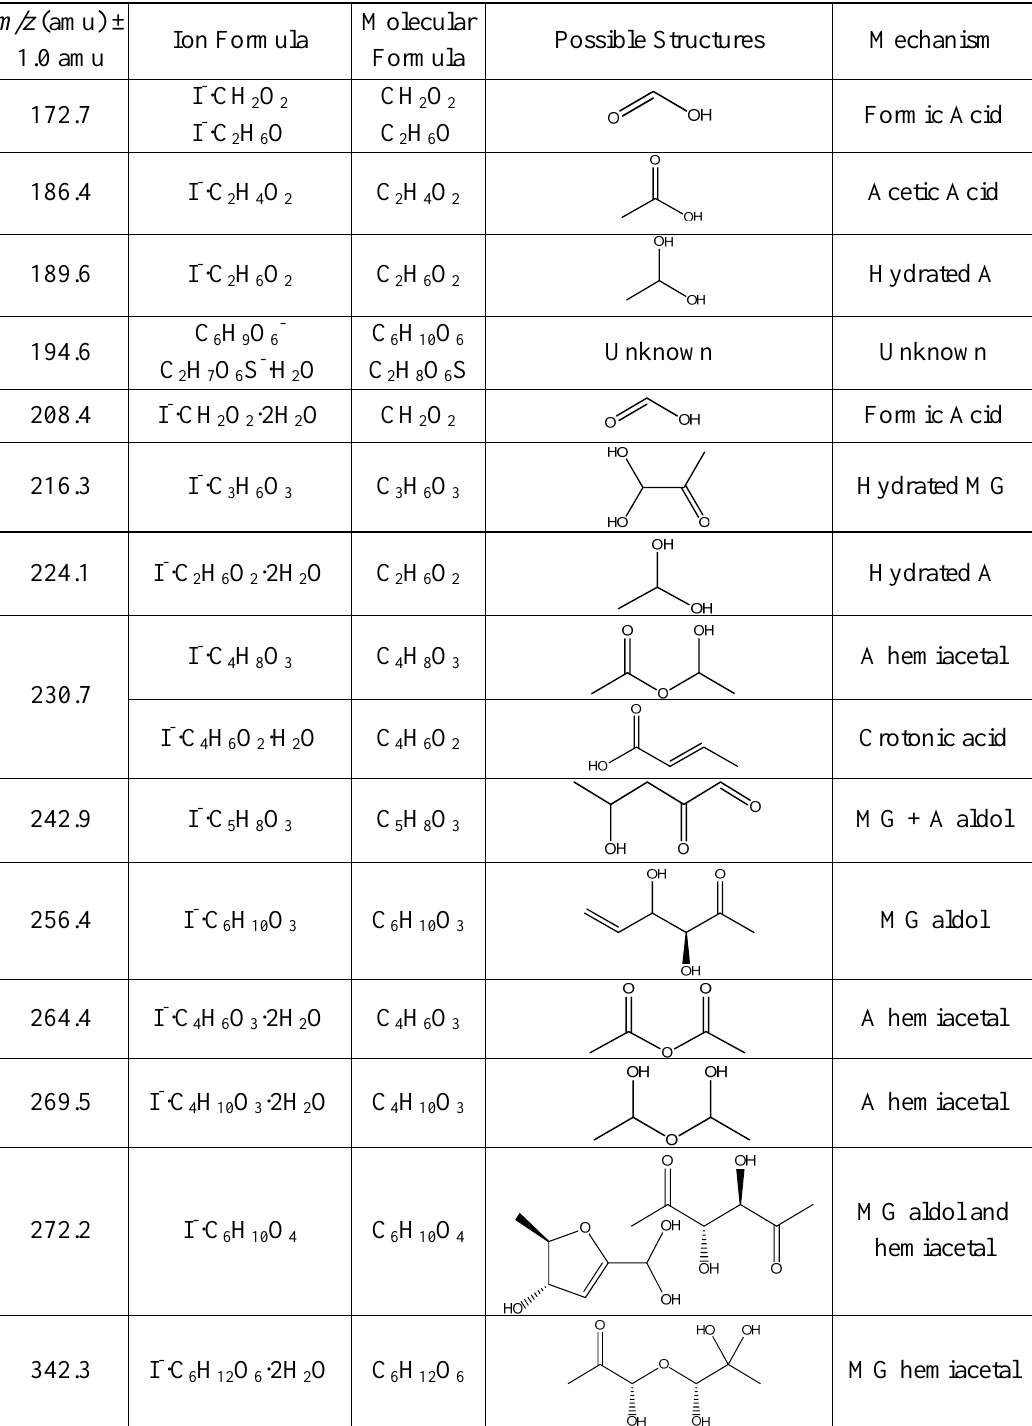
Table 5. Proposed peak assignments for Aerosol-CIMS mass spectra with I − of atomized solutions of 2 M acetaldehyde/MG (1:1) in 3.1 M AS.